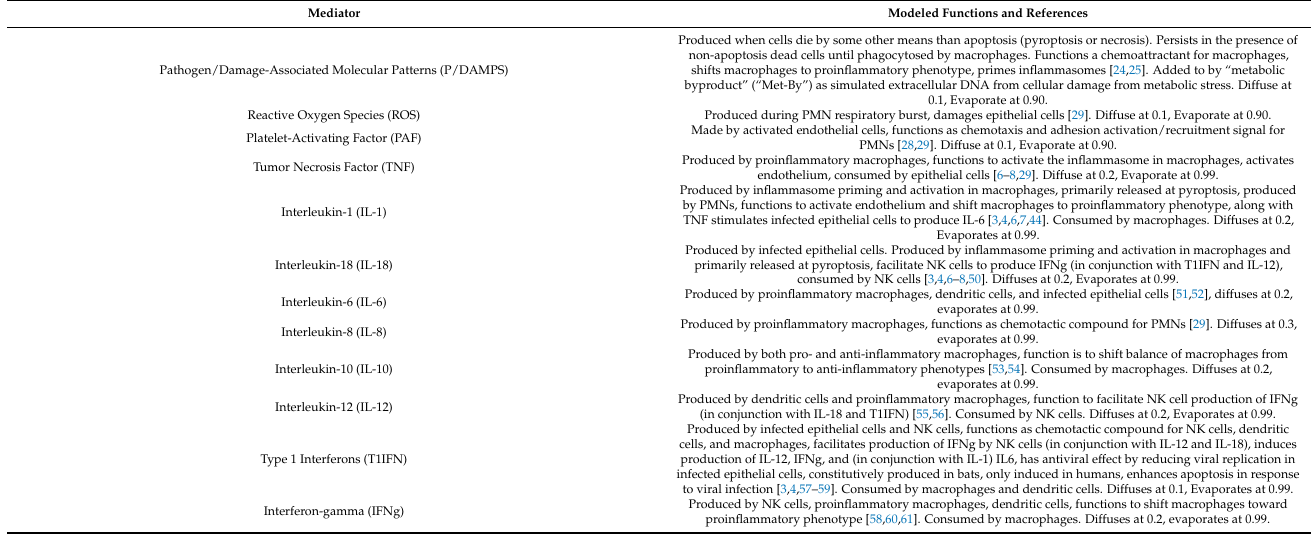
Table A1. Mediators Represented in the CBIABM, Their Functions in the Model, and Associated References. Mediator